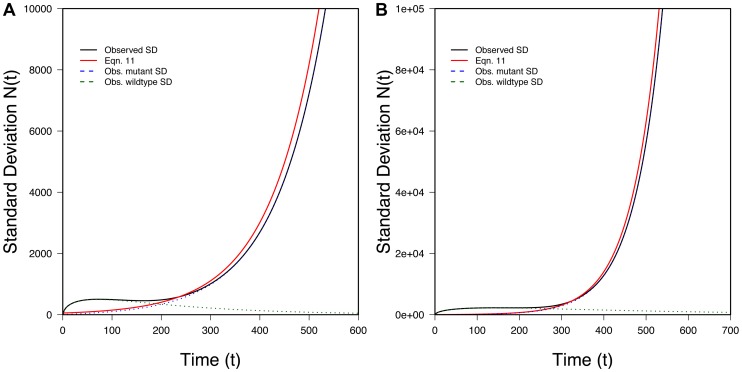
The variance in population size during evolutionary rescue.Observed variance of total population size (black), predicted from Eq. 11 (red), variance in the number of mutants (dotted blue), variance in number of wildtype (dotted green). A) N0 = 10,000, r = 0.01, s = 0.02, k = 10; B) N0 = 100,000, r = 0.005, s = 0.02, k = 3; 100;000 realizations.